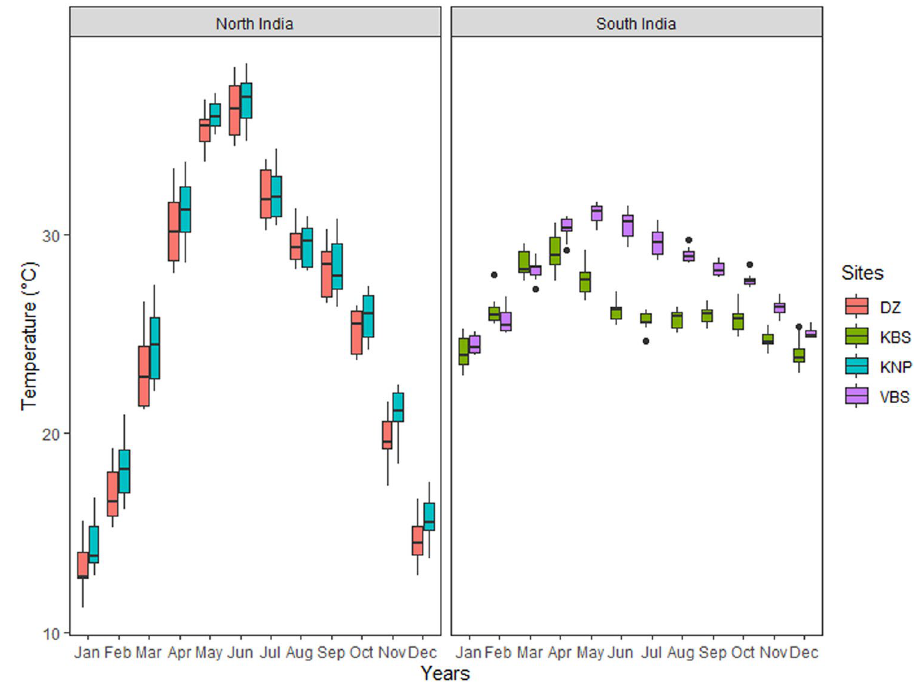
Figure 2. Monthly variation of Temperature (at 2 m from ground level) at the study sites during 2010– 2020 years ( DZ Delhi Zoo, KBS Koonthankulam Bird Sanctuary, KNP Keoladeo National Park, VBS Vedanthangal Bird